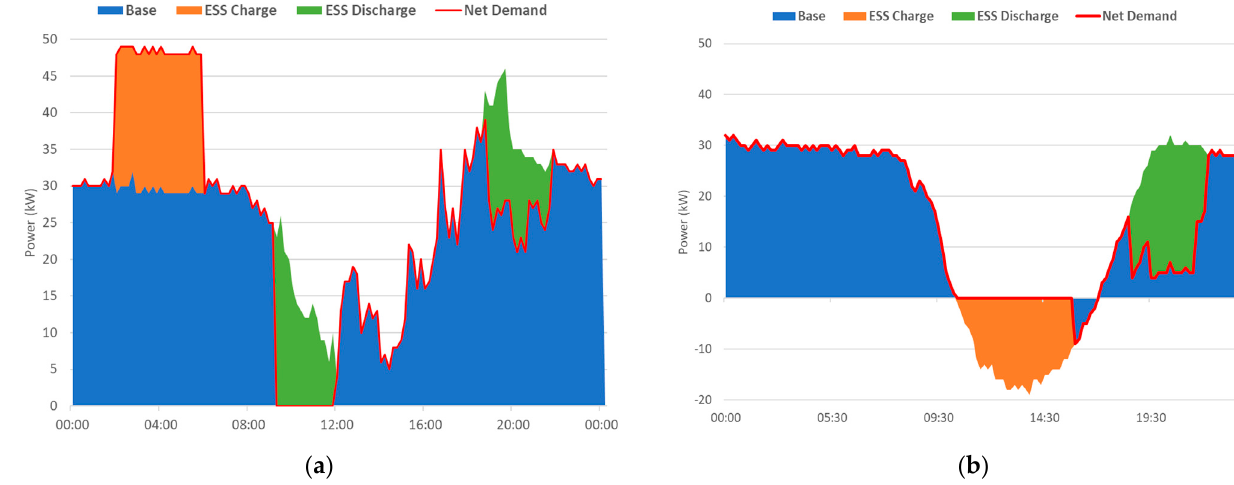
Figure 10. Scenario B: weekday ( a ); weekend ( b ).